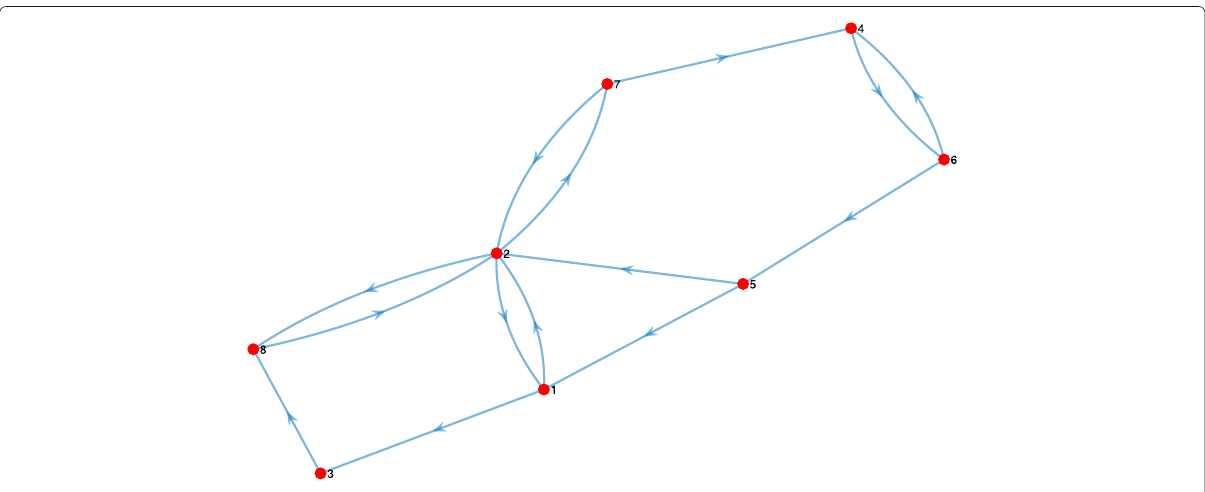
Fig. 1 A strongly connected and unbalanced directed graph